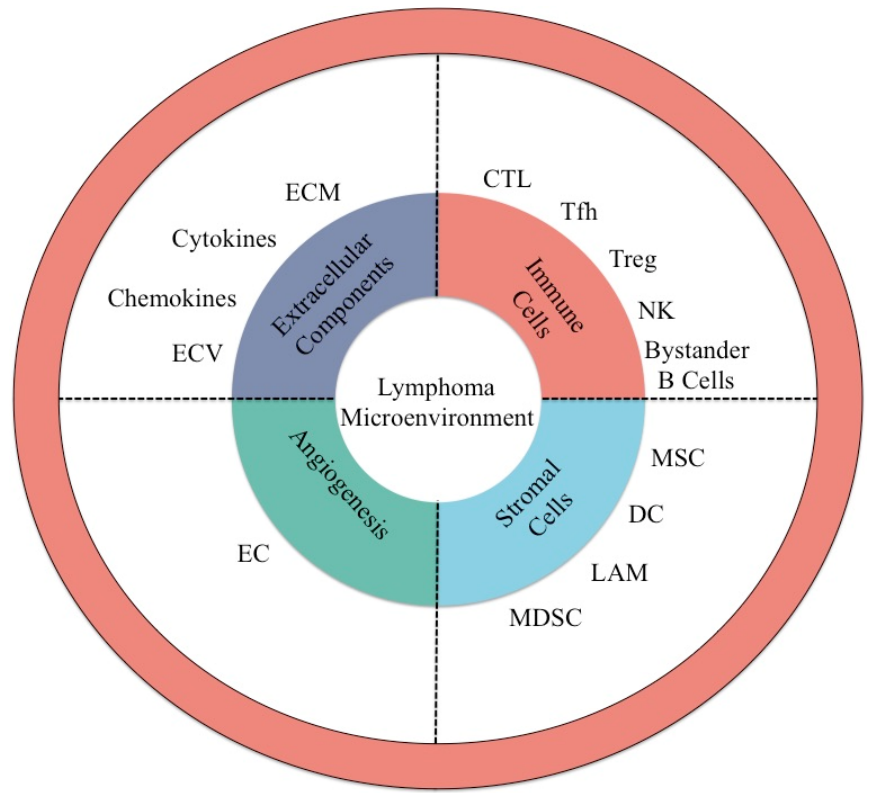
Figure 2. The role of extracellular matrix in lymphoma development and progression. The vascular network is disorganized and it has larger pores than normal blood vessels, due to overexposure to VEGF, PDGF- β , and TGF- β . Due to these characteristics, the local microenvironment is hypoxic and there is a general lack of systemic immune cell provision, while the local immune cells secrete cytokines meant to facilitate lymphoma cell proliferation and invasion. The macrophage is polarized to the M2 phenotype and secretes IL-10, the TFH cells secrete IL-21, and the Th17 and CD8 + T cells secrete IL-6. However, the main mechanism through which the lymphoma progression is sustained by the extracellular environment is due to the secretion of exosomes by immune cells (T or B lymphocytes) and lymphoma cells (of B or T origin). The exosomes contain at their surface, targeting molecules, such as tetraspanins (CD9, CD63, and CD81), major histocompatibility complex (MHC) (I and II), and integrins. In their interior, the exosomes have nucleic acids: DNA in the form of fusion genes (EML4-ALK), long non-coding RNAs (lncRNAs), circular RNAs (circRNAs), and miRNAs. The exosomes also contain SNARE, annexin, lotilin, Alix, TSG101, and mutated forms of proteins, such as mutMYD88.